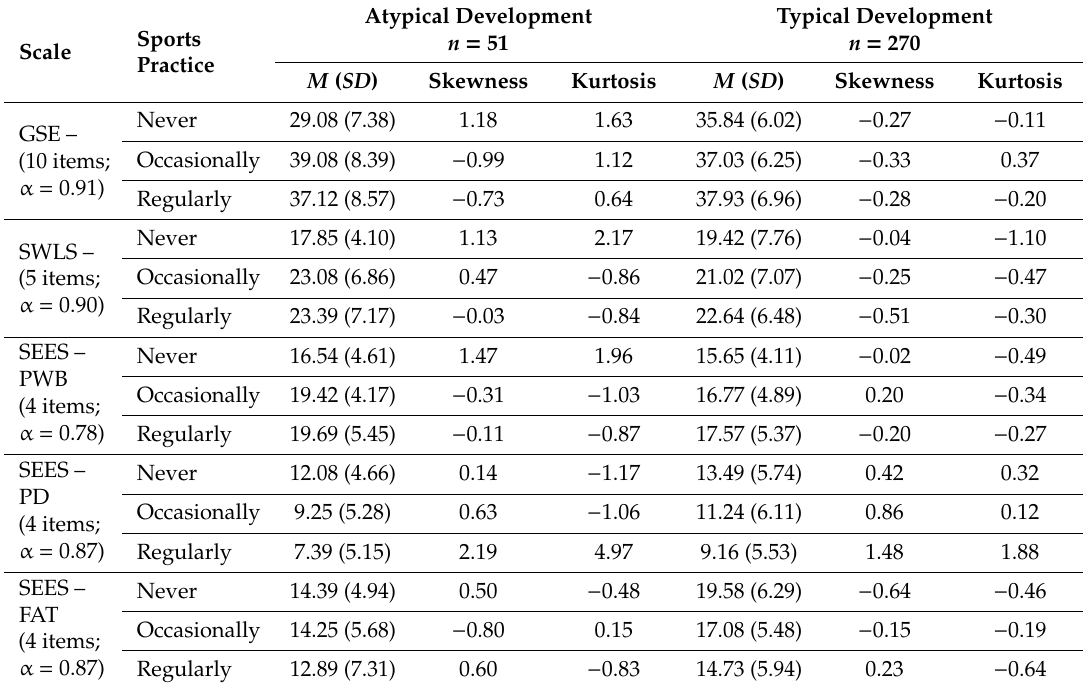
Table 2. Descriptive statistics of General Self E ffi cacy Scale (GSE), Satisfaction with Life Scale (SWLS), and The Subjective Exercise Experiences Scale